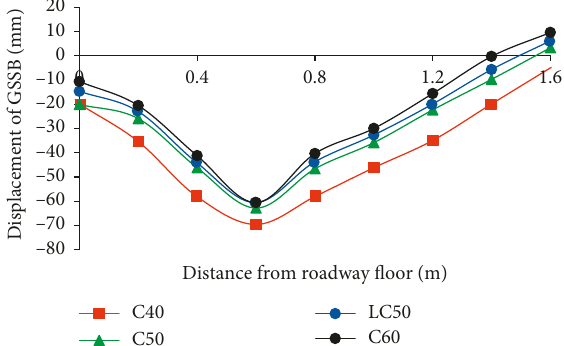
Figure 27: Displacement of the supporting body